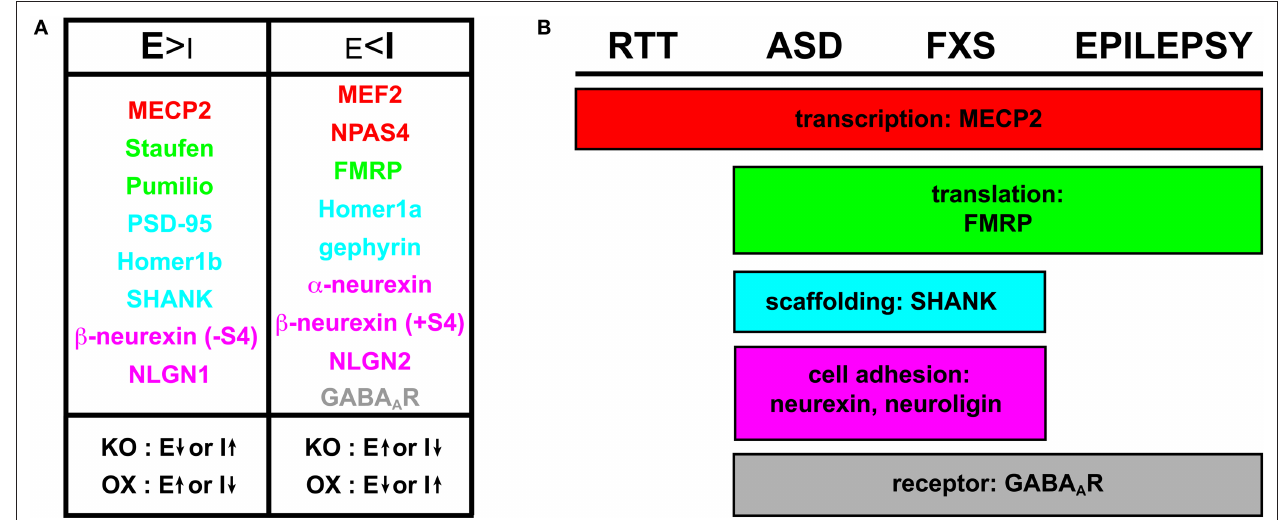
FiGure 3 | Molecular players influencing E/I ratio and commonalities in neurodevelopmental disorders. (A) Molecular regulators of E/I synaptic balance include transcriptional regulators (red), translational regulators (green), scaffolding proteins (blue), cell adhesion molecules (magenta) and receptors (gray). Components that promote excitatory synapse formation ( E > I ) are evident when knockout (KO) or knockdown yields depressed E or elevated I ; likewise, over-expression (OX) of an excitation-favoring element yields elevated E or depressed I . With the converse class of regulators, inhibitory synapse